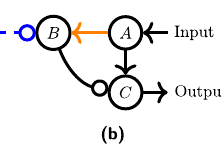
Figure 4: The two reaction networks that can achieve perfect adaptation [ 17 ] . ( a ) NFBN network, and ( b ) IFFLP network. Orange edges represent saturated reactions, blue edges represent linear reactions, and black edges are unconstrained reactions. Arrowheads represent positive in fl uence and edges ending with a circle represent negative in fl